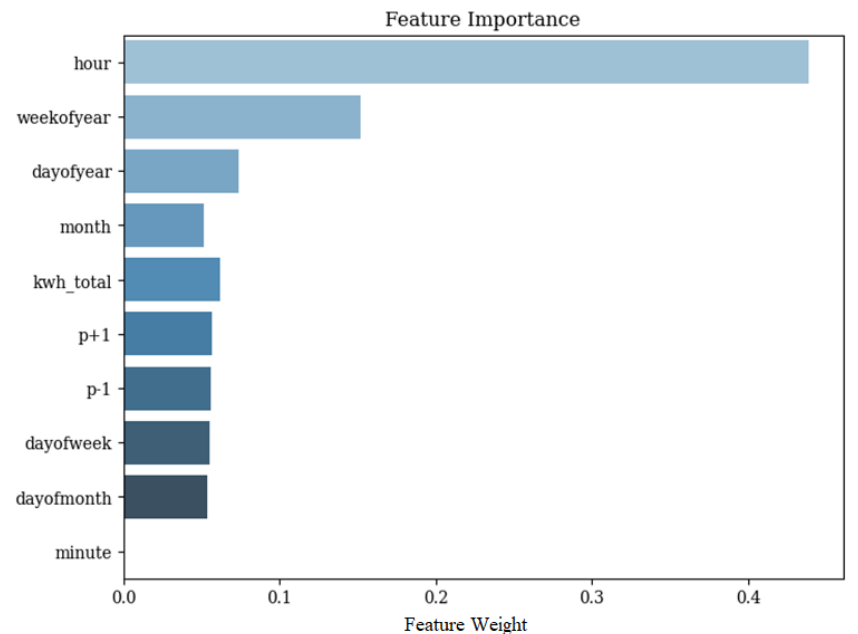
Figure 8. Importance of features for the prediction model of one of the project residences.